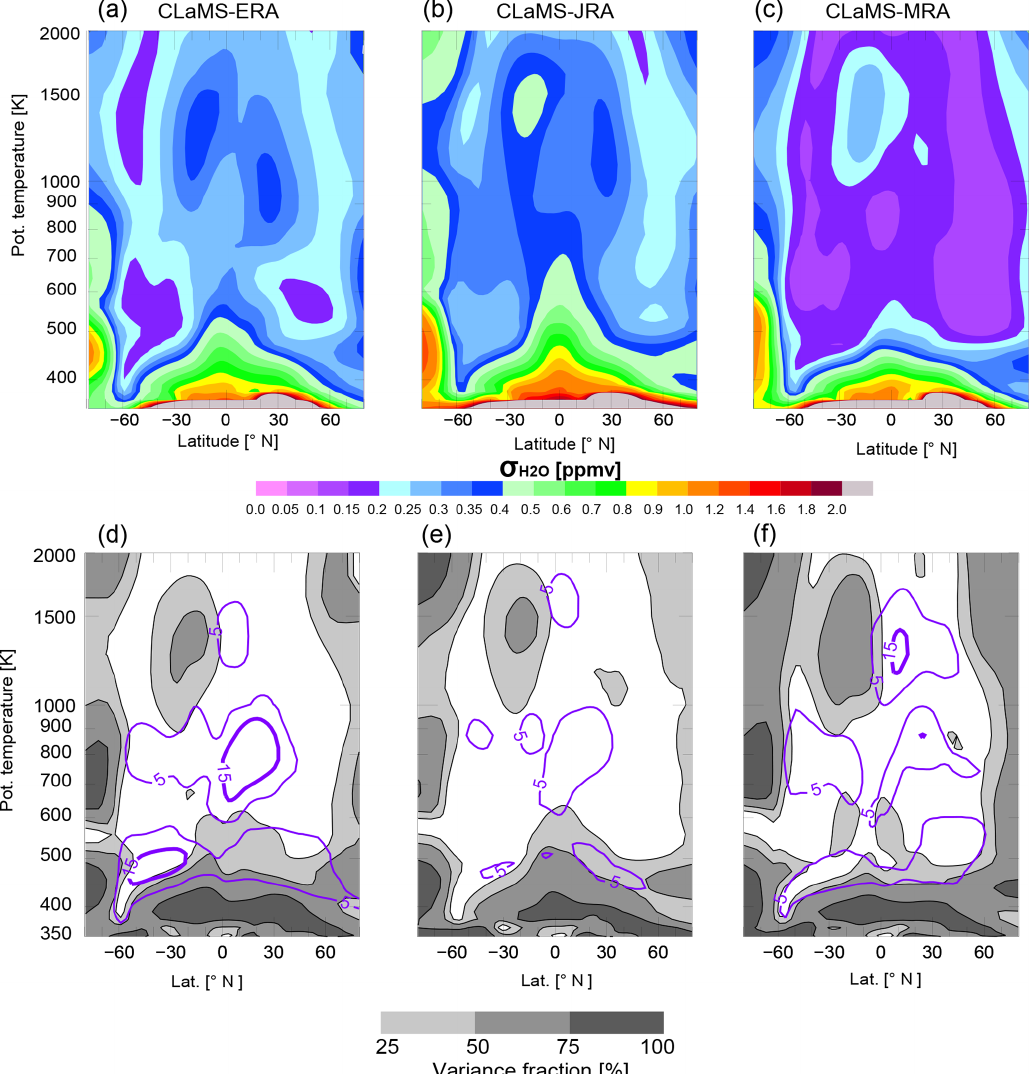
Figure 10. The standard deviation in monthly-mean H 2 O ( σ χ ; upper row) and the fraction of AC and QBO variance relative to total variance (in %; d , e , f ) for CLaMS-ERA (a, d) , CLaMS-JRA (b, e) and CLaMS-MRA (c, f) . Shading in the lower panels shows the variance fraction /σ 2 χ ), while purple contours show the variance fraction attributed to the QBO ( σ 2 χ attributed to the annual cycle ( σ 2 χ AC